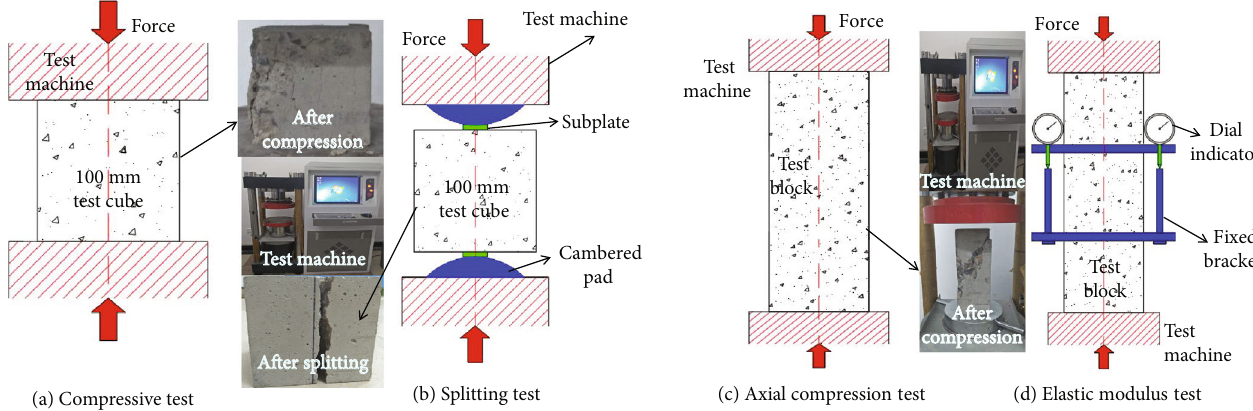
Figure 3: Test of cube compressive strength (a), splitting strength (b), axial compressive strength (c), and elastic modulus (d).